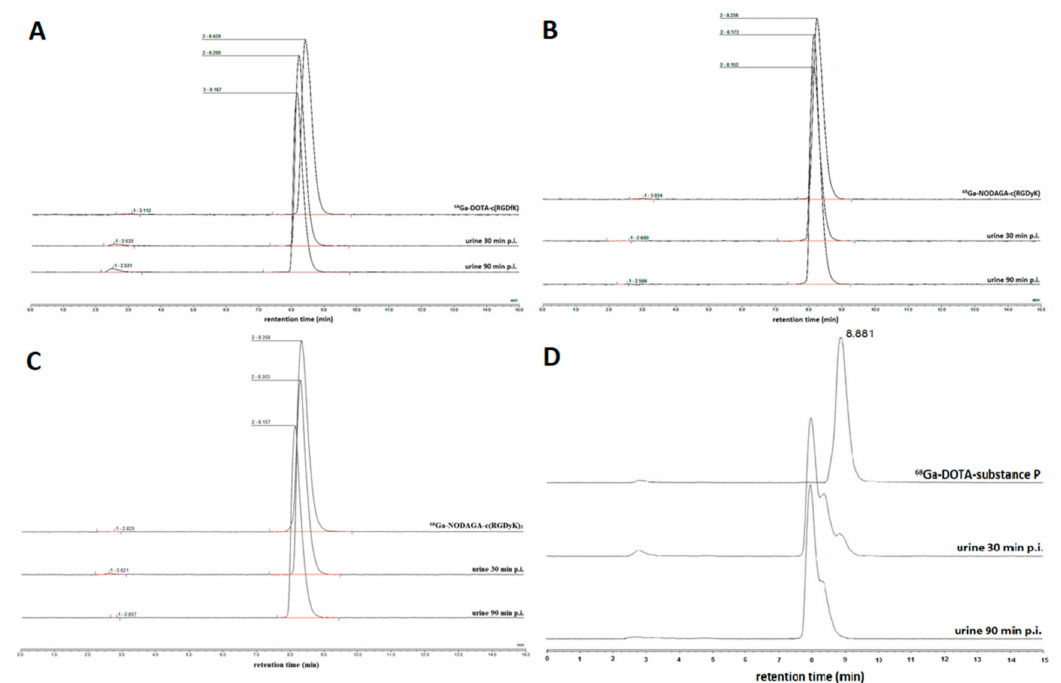
Figure 2. HPLC radiochromatograms of ( A ) 68 Ga-DOTA-c(RGDfK), ( B ) 68 Ga-NODAGA-c(RGDyK), ( C ) 68 Ga-NODAGA-c(RGDyK) 2 , and ( D ) 68 Ga-DOTA-substance P. The upper line in every chromatogram represents the tracer before the application to animals; the other two are samples of urine 30 min p.i. and 90 min